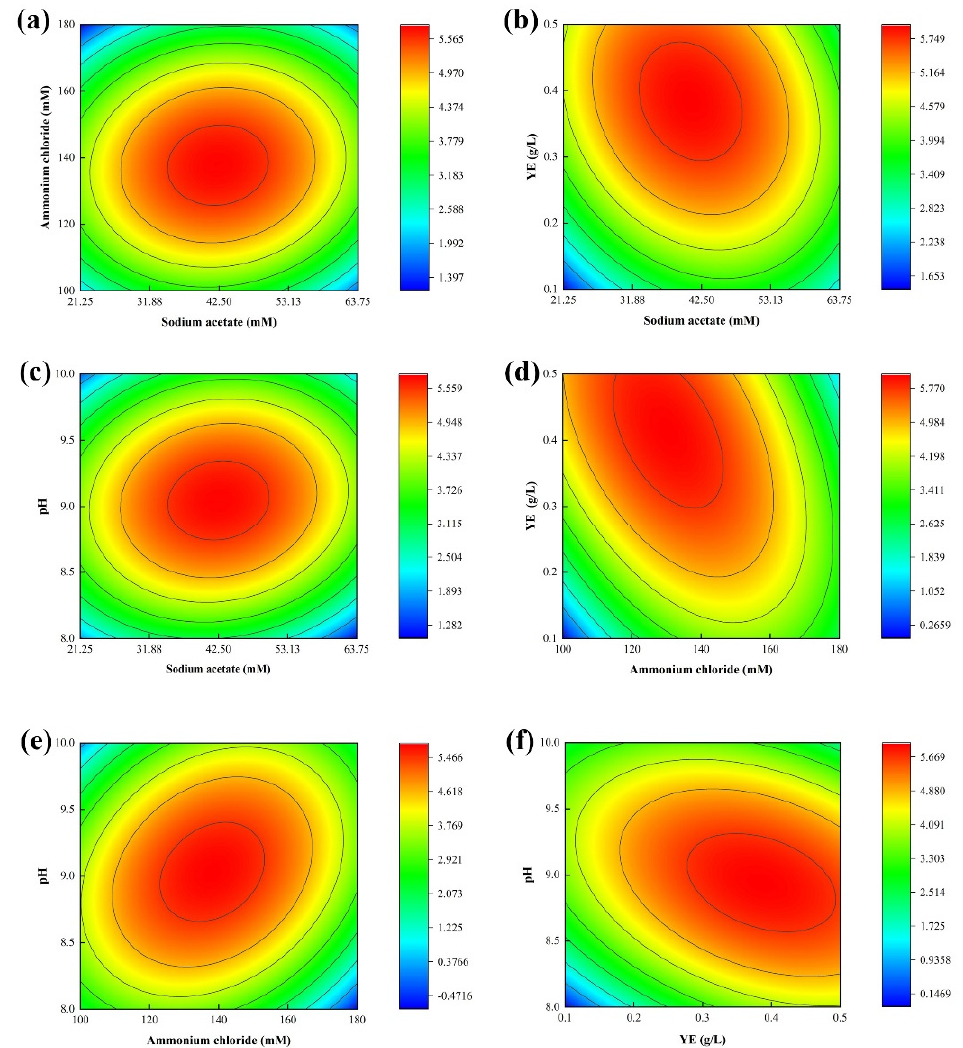
Figure 6. Contour plots of urease activity under the influence of two factors: ( a ) sodium acetate and ammonium chloride; ( b ) sodium acetate and YE; ( c ) sodium acetate and pH; ( d ) ammonium chloride and YE; ( e ) ammonium chloride and pH; ( f ) YE and pH.